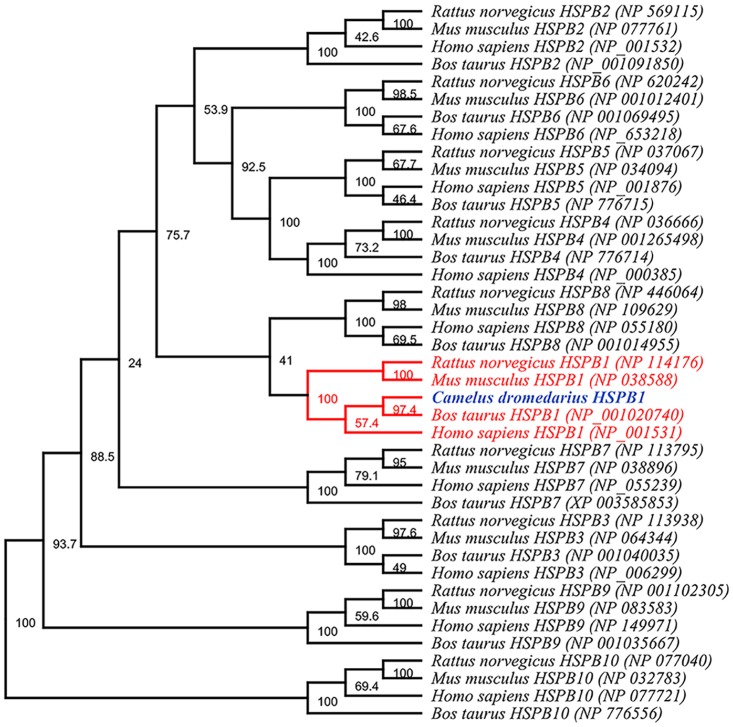
Phylogenetic tree shows the classification of Arabian camel HSPB-1 within the sHSPB family.